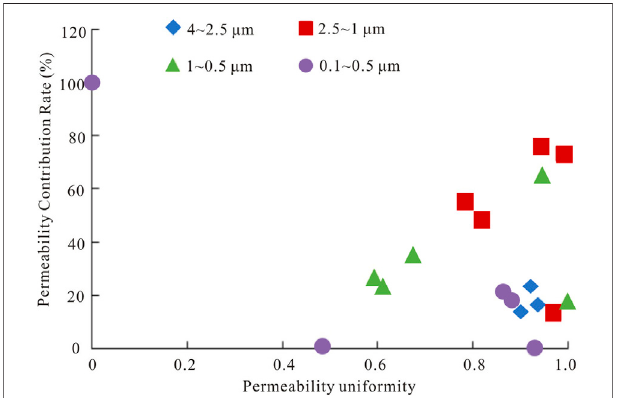
FIGURE 8 | Relationship between uniformity at different scales and permeability contribution of throats.